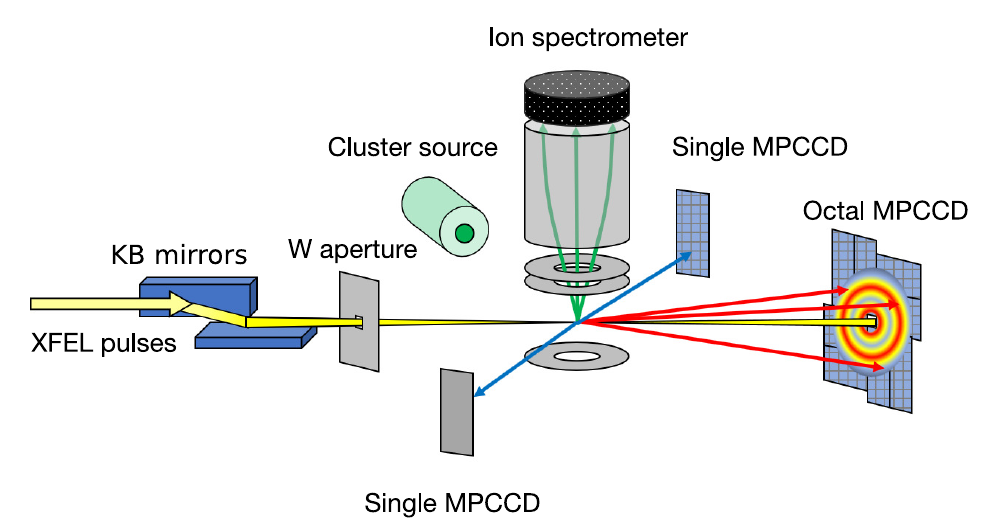
Figure 1. Schematic of the experimental setup. X-ray free-electron laser (XFEL) pulses were focused by a pair of Kirkpatrick–Baez (KB) mirrors. The cluster beam was generated through adiabatic expansion and introduced through two skimmers to the reaction point. The scattered photons were collected by an octal multiport charge-coupled device (MPCCD) sensor installed 1.5 m from the reaction point in the direction of XFEL beam. Fluorescence photons were detected by two single MPCCD sensors, whose distances from the reaction point were 0.6 m and 0.8 m, respectively. Ions were collected by an ion time-of-flight (TOF) spectrometer, set on the upper side of the